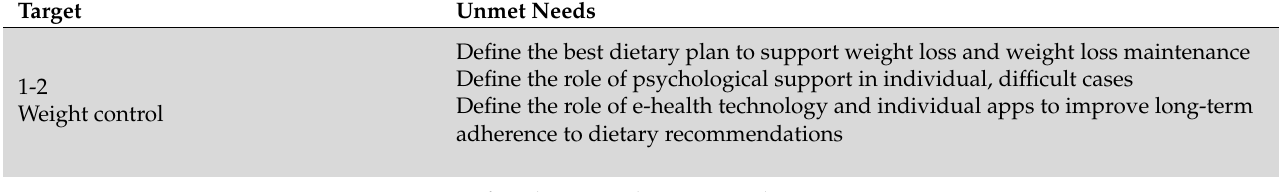
Table 4. Principal unmet needs for optimal nutritional treatment of patients with type 2 diabetes.